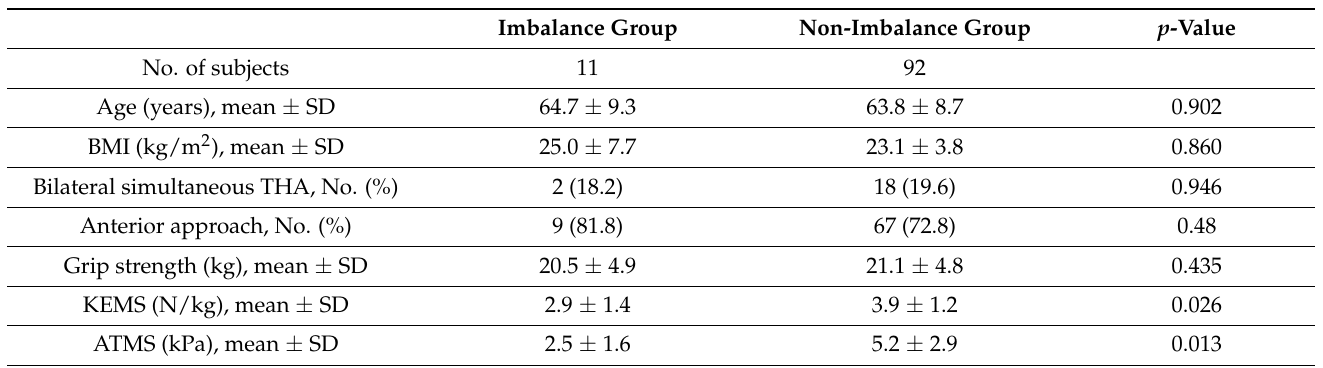
Table 1. Demographic and radiographic parameters of 103